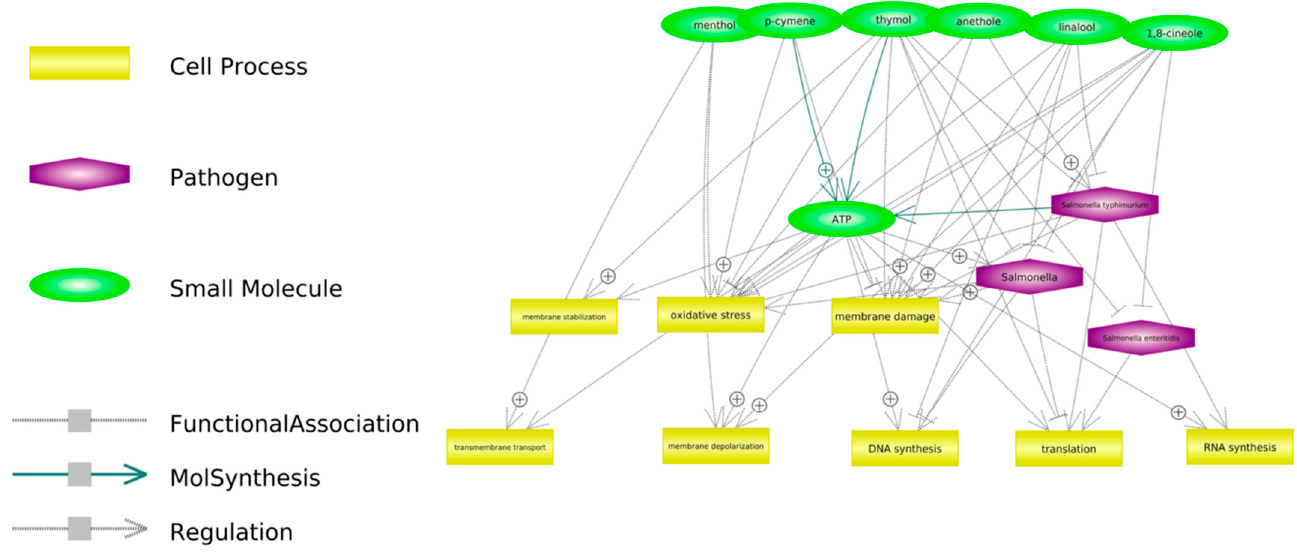
Figure 2. Potential antibacterial activity of selected components of phytobiotics mixture used in the study. The links were created in the Pathway Studio Web (USA) software on the basis of available publications.